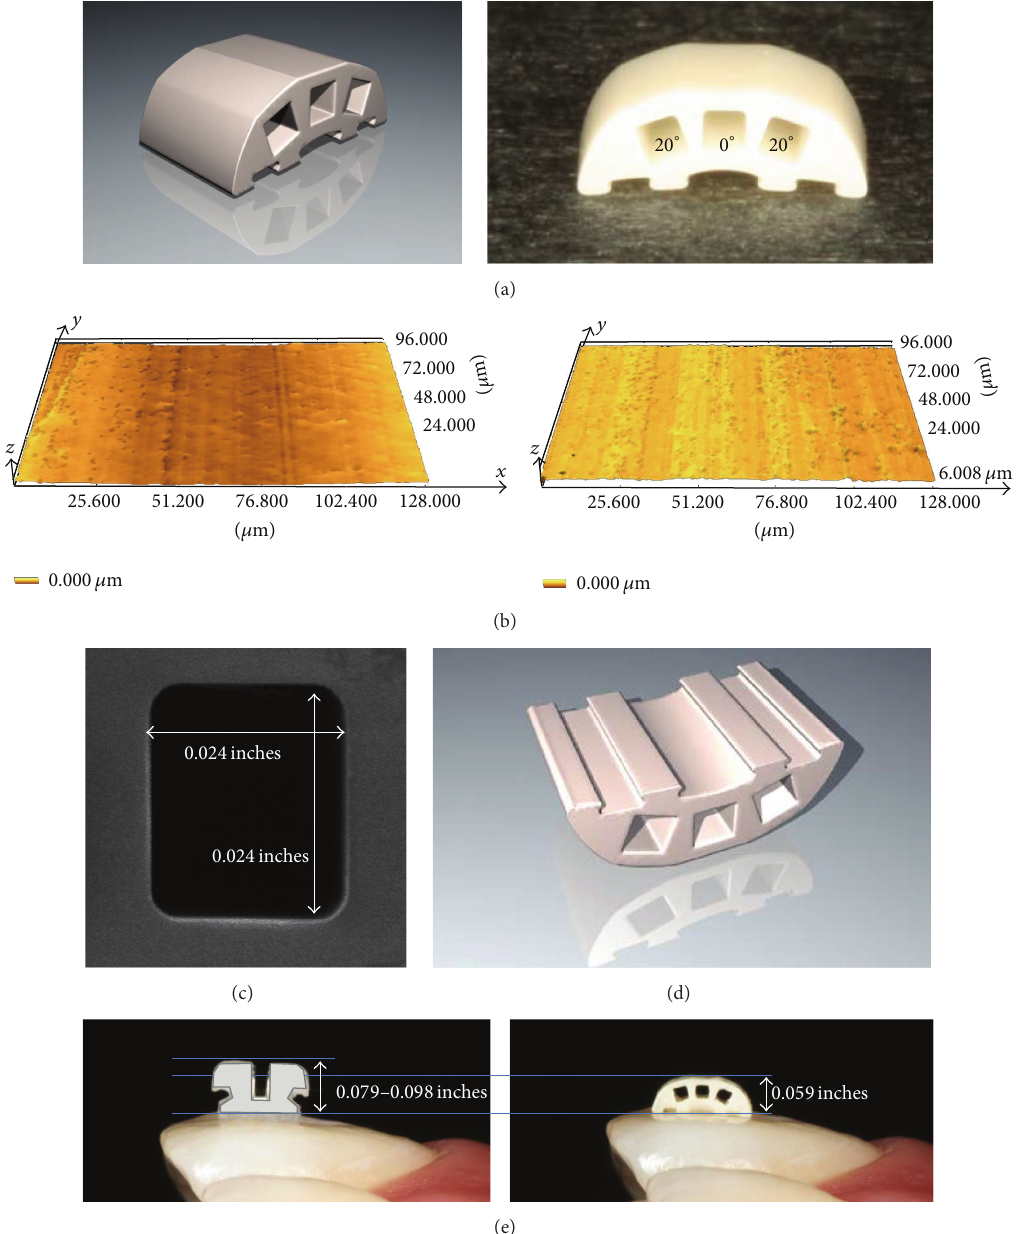
Figure 1: (a) Spherical structure of the bracket surface and slot torque; (b) bracket surface (left) and internal surface (right) of slots (laser microscope, magnification x100) (GC ORTHOLY CORPORATION, Tokyo, Japan); (c) slots (scanning electron microscope, magnification x20); (d) base; and (e) size. Conventional brackets for the anterior tooth area (left) and a new zirconia bracket with multiple slots